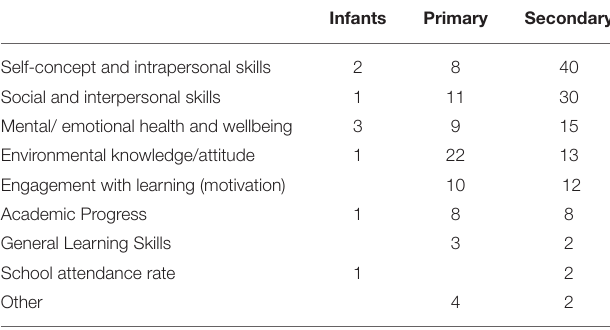
TABLE 2 | Number of studies by outcome type and